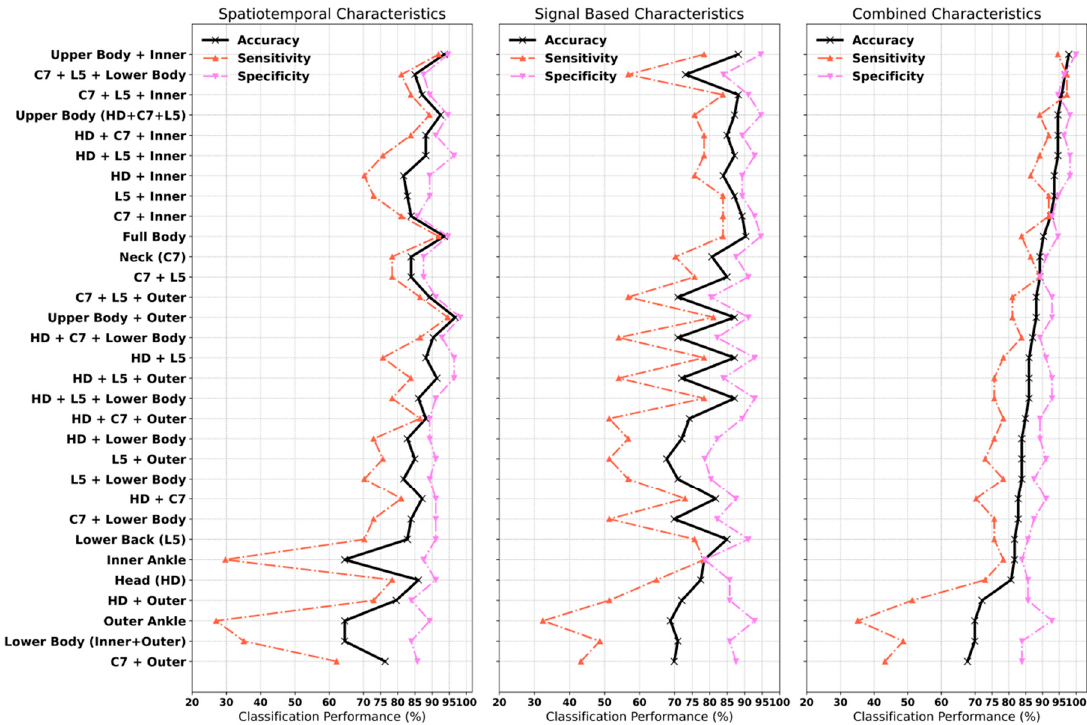
Figure 5. Classification performance of partial least square discriminant analysis (PLS-DA) trained on various combinations of IMU locations HD; head, C7; neck, L5; lower back, Inner; inner ankle, Outer; Outer ankle.